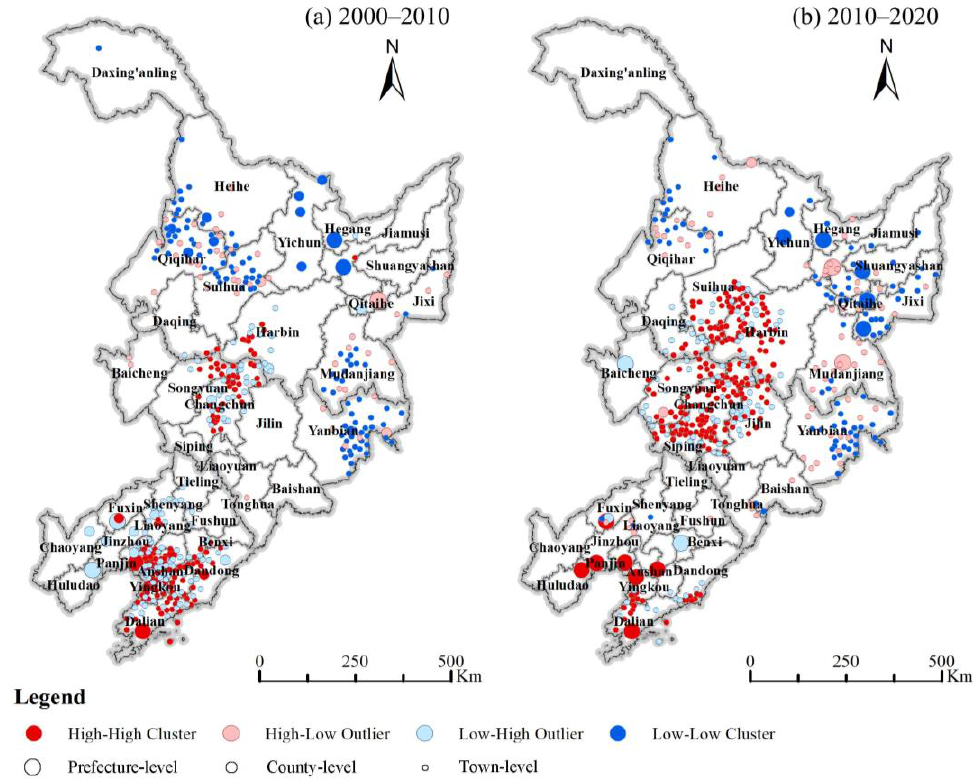
Figure 5. Local spatial autocorrelation of multi-level town shrinkage in Northeast China. Subfigure ( a ) shows the local spatial autocorrelation of multi-level town shrinkage in Northeast China during the period 2000 – 2010; Subfigure ( b ) shows the local spatial autocorrelation of multi-level town shrinkage in Northeast China during the period 2010 – 2020.